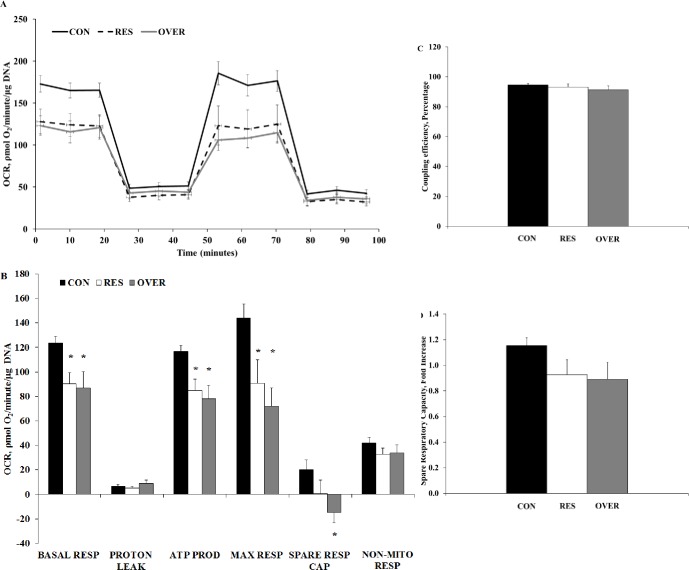
Poor maternal nutrition decreases the oxidative phosphorylation capacity of offspring mesenchymal stem cells.Mesenchymal stem cells were obtained from the offspring of control-fed (CON, n = 6), restricted-fed (RES, n = 6), and over-fed (OVER, n = 5) ewes at 1 day of age. Data are presented as mean ± standard error. * denotes P < 0.05. (A) Oxygen Consumption Rate (OCR), an indicator of oxygen-dependent mitochondrial ATP production, was measured when MSC were subsequently exposed to Oligomycin, FCCP, and Rotenone/Antimycin. (B) Calculation of basal respiration (BASAL RESP), proton leak (PROTON LEAK), ATP production (ATP PROD), maximal respiration (MAX RESP), spare respiratory capacity (SPARE RESP CAP), and non-mitochondria-derived respiration (NON-MITO RESP) of MSC, presented as mean ± standard error (C) Coupling efficiency (COUPLING EFF), represented as a percentage ± standard error (D) SPARE RESP CAP presented as a fold increase ± standard error.